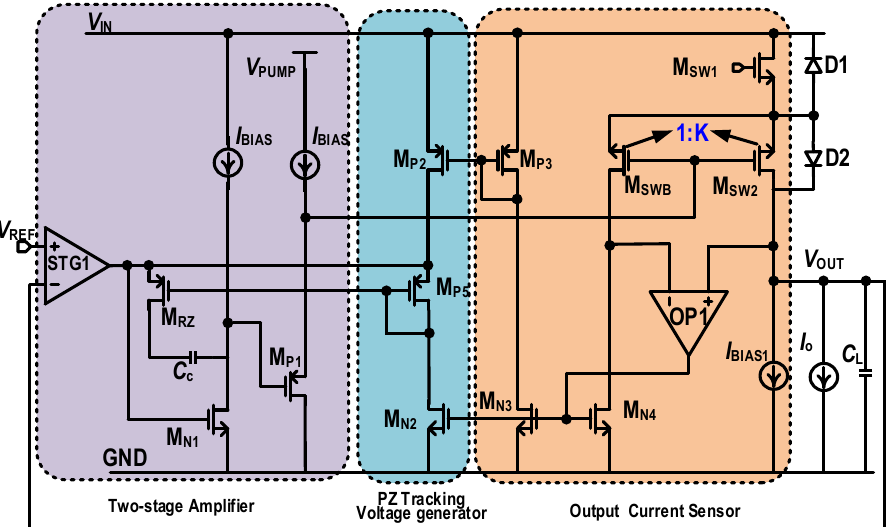
Figure 2. Typical traditional pole–zero tracking compensation circuit.